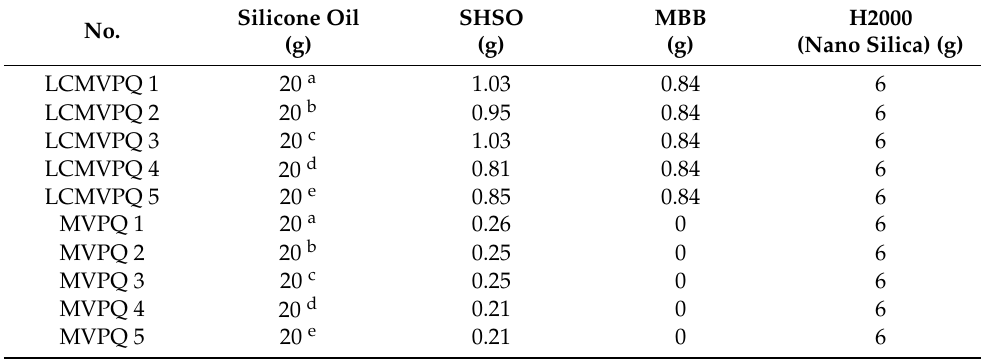
Table 2. The composition of synthesized LCMVPQs and MVPQs.